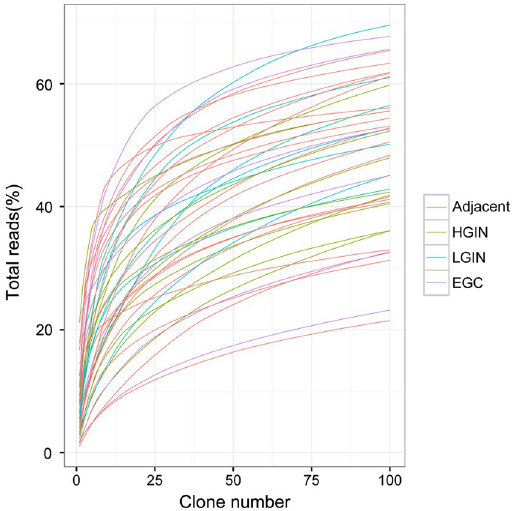
Figure 1. Characteristics of the TCR repertoire frequency distribution. The cumulative frequencies of the TOP100 in each sample are shown. The x-axis depicts the number of clones included (starting from the most expanded clones). The y-axis shows the cumulative percentage of TCR β sequences that are covered by the included clones.